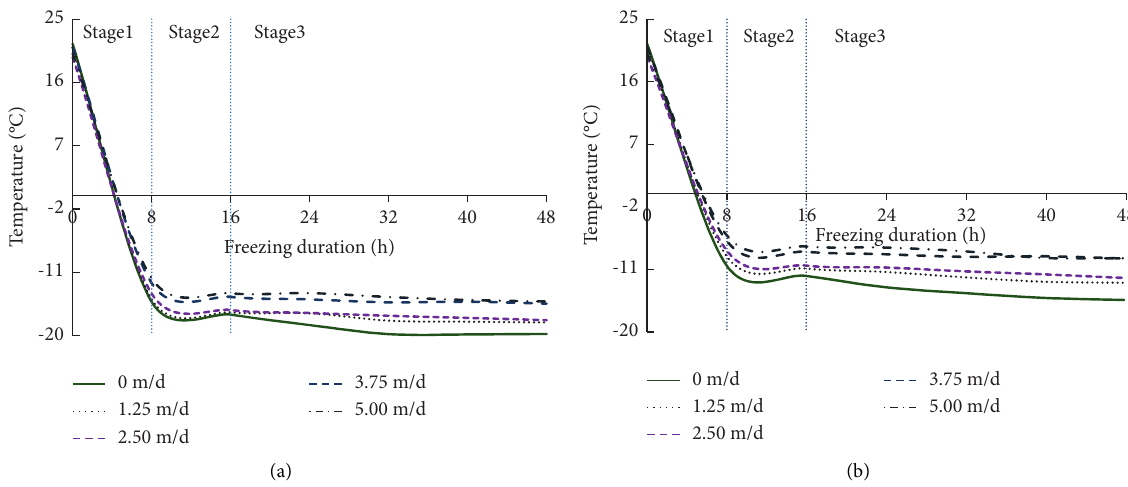
Figure 5: Time history of the brine temperature and freezing pipe wall temperature. (a) Brine in the freezing pipe in physical modelling. (b) Freezing pipe wall in physical